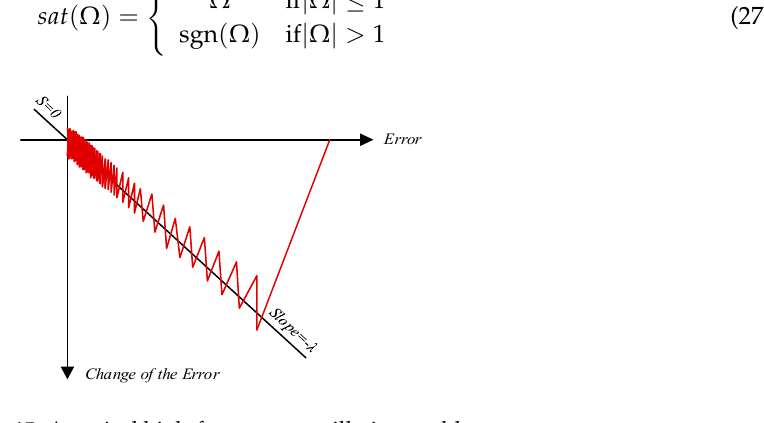
Figure 15. A typical high-frequency oscillation problem.